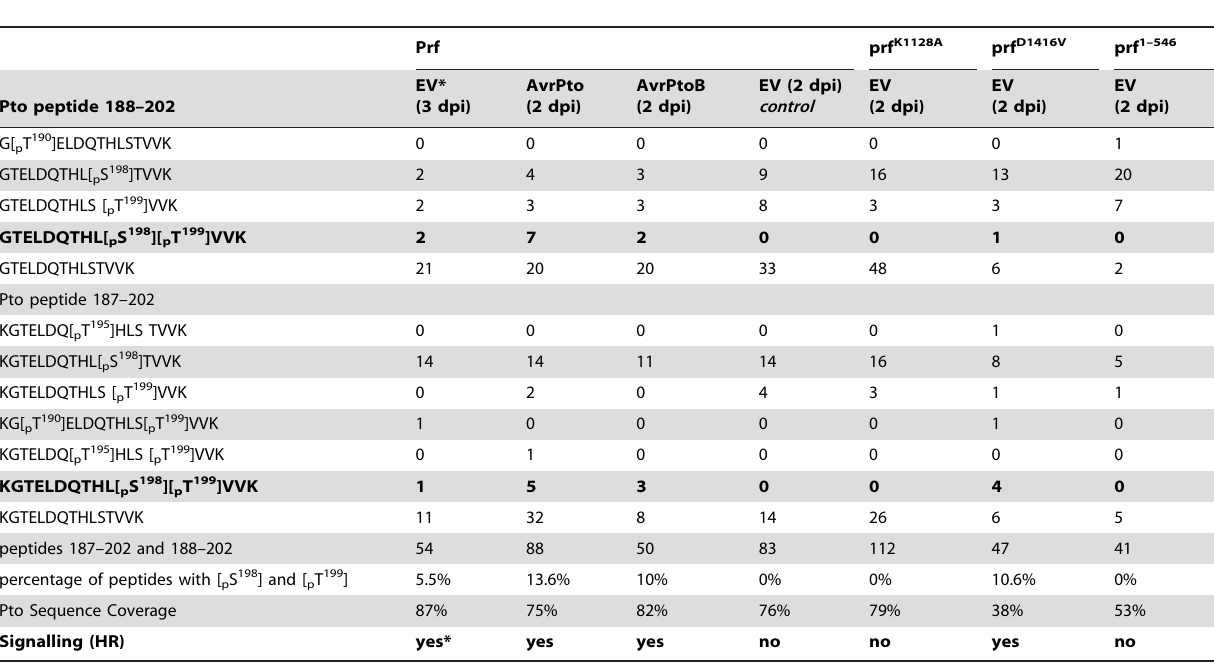
Table 1. Double phosphorylation of Pto peptide 187–202 and 188–202 upon activation of signalling.